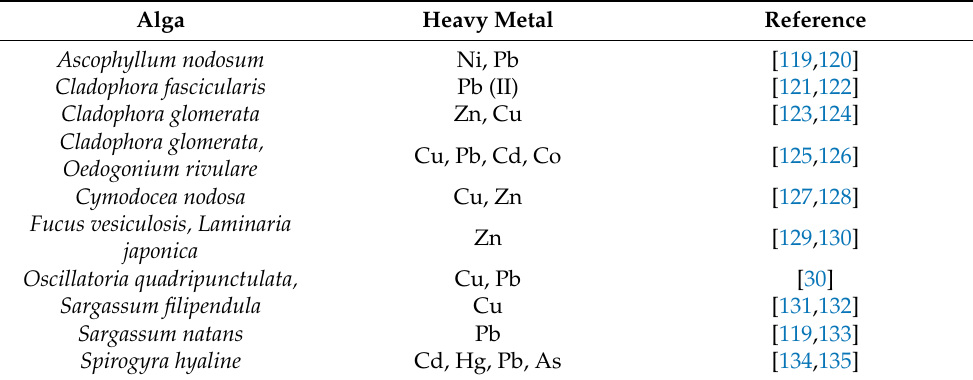
Table 2. Exertion of soil algae for heavy metal decontamination by